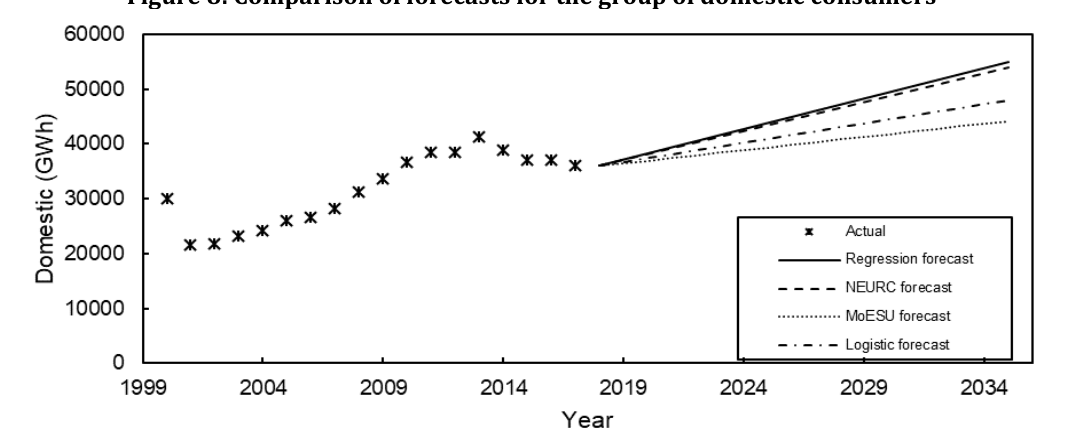
Figure 8: Comparison of forecasts for the group of domestic consumers